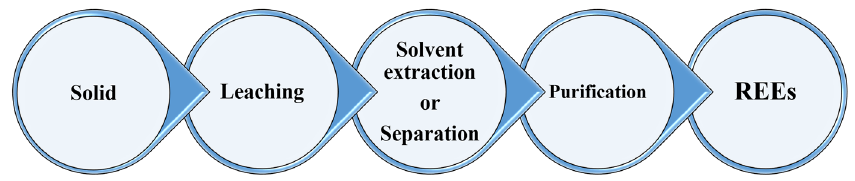
Figure 1. Representation of separation and purification procedures of rare earth elements.